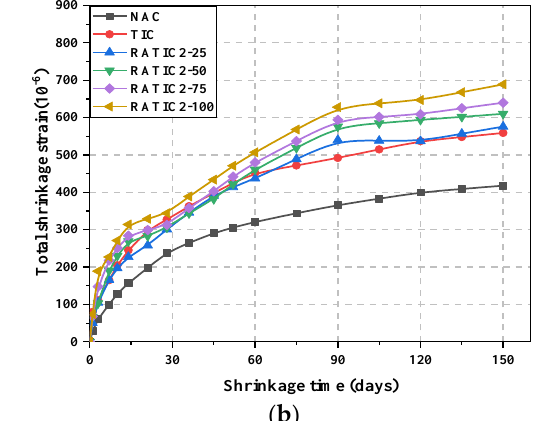
Table 8. Thermal conductivity of RATIC (W/(m · K)).